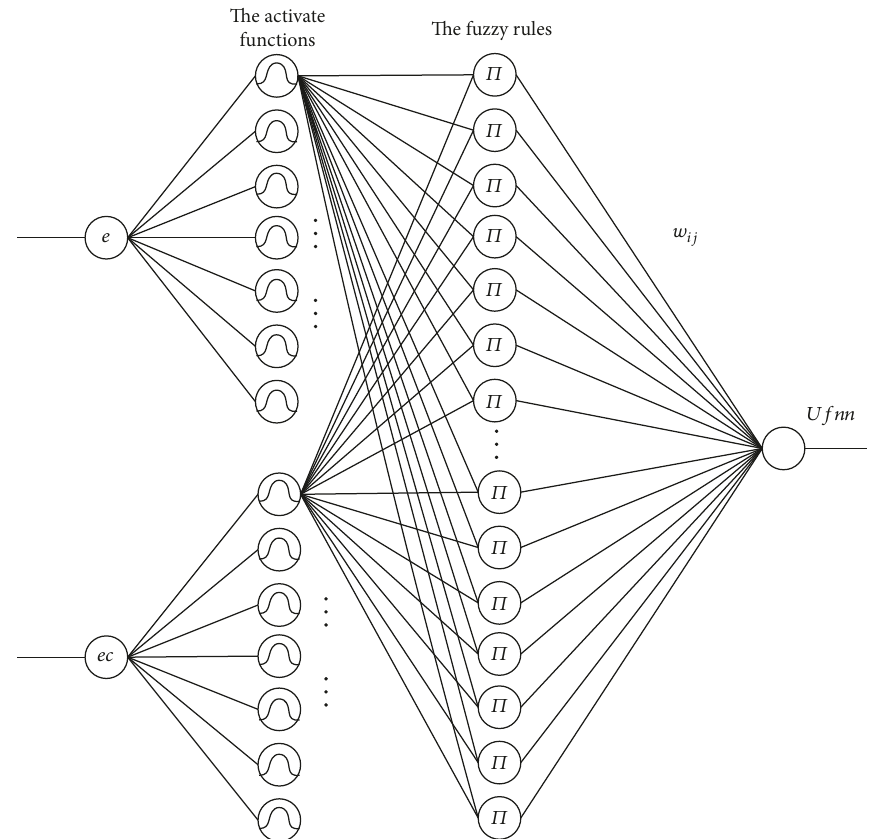
Figure 7: The front topological structure of the